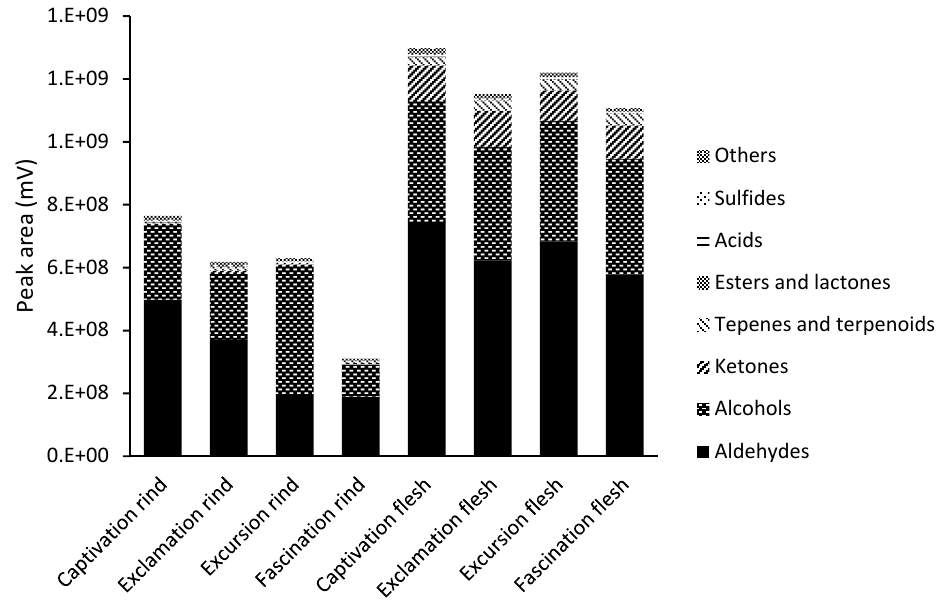
Figure 1. Group of volatiles (sum of peak areas, millivolts (mV)) in the rinds and fleshes of four watermelon cultivars of Captivation, Exclamation, Excursion, and Fascination using SPME-GC-MS analysis.